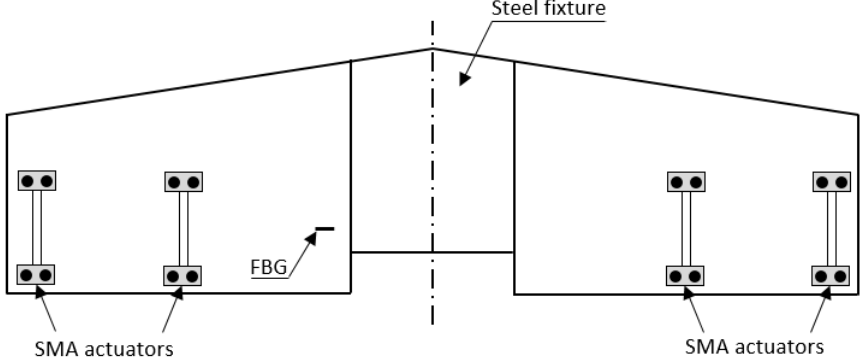
Figure 22. Scheme of the smart composite wing experiment (adapted from